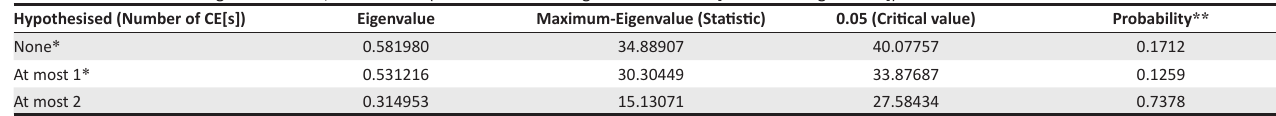
TABLE 3b: Johansen cointegration results, 1980–2012. (Unrestricted Cointegration Rank Test [maximum-eigenvalue]) Hypothesised (Number of CE[s])